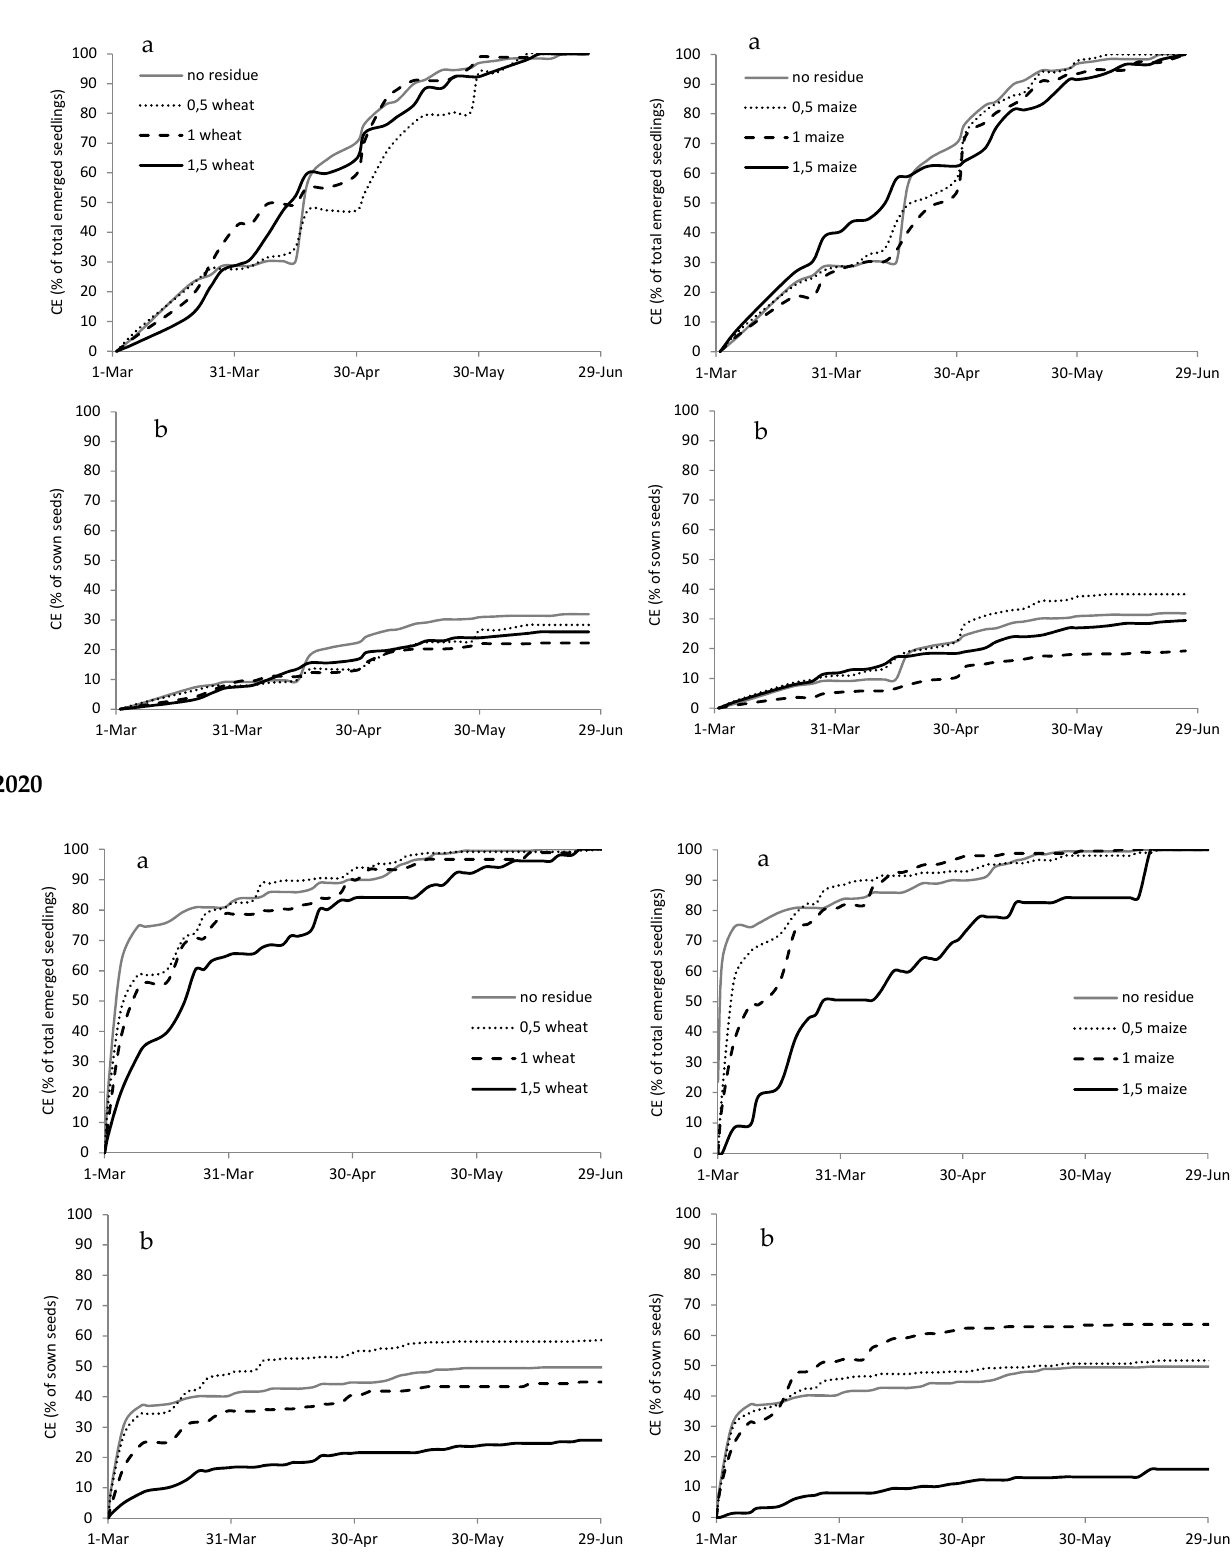
Figure A7. Cumulated emergence (CE) expressed as percentage of total emerged seedlings ( a ) and as percentage of sown seeds ( b ) of Sonchus oleraceus in 2019 and 2020 with different types (wheat on the left and maize on the right) and amounts of crop